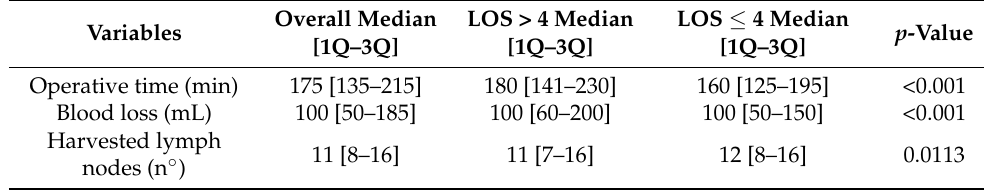
Table 7. Univariable linear regressions of variables possibly associated with a longer length of hos- pital stay.